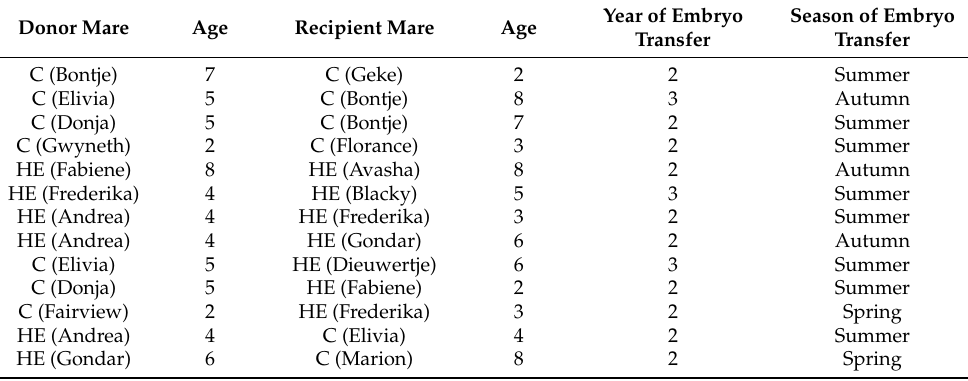
Table 2. Composition of the subgroups (C-C, C-HE, HE-C and HE-HE), including the names of the individual ponies, their age, and the year and season in which embryo transfer and conceptus recovery was